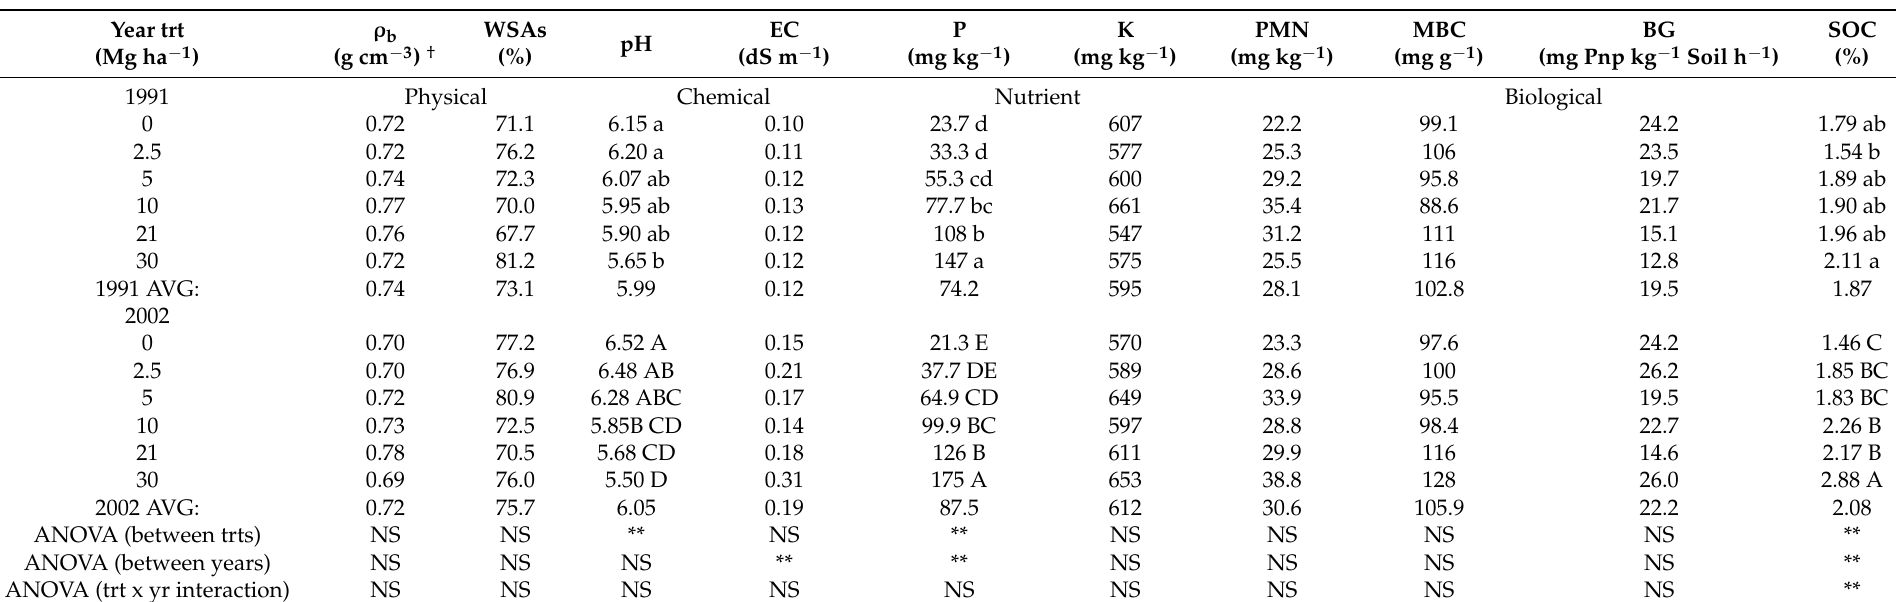
Table 2. Mean soil indicator characteristics (0–15 cm depth; collected in 2018) as affected by increasing single (applied in 1991) or repeated (applied in 2002) biosolids applications to a degraded rangeland at the Fort Collins, Colorado, USA Meadow Springs Ranch. When present, different letters between treatments within a given application year represent significant differences at the p < 0.05